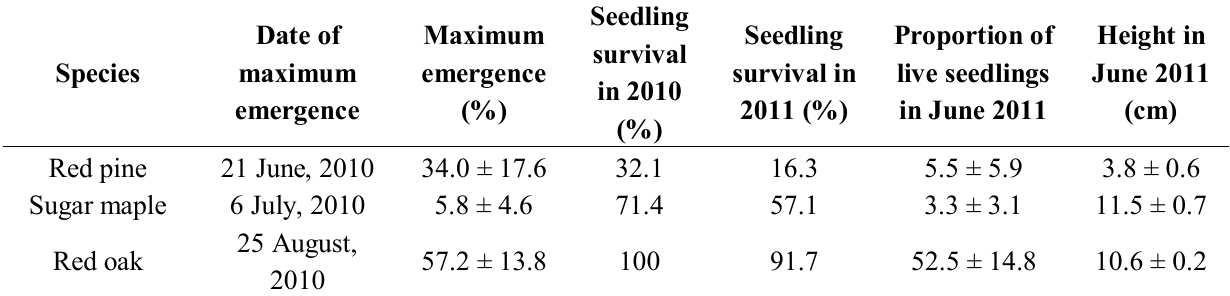
Table 2. Seedling emergence, survival and height of red pine, sugar maple and northern red oak. Date of Species Red pine Sugar